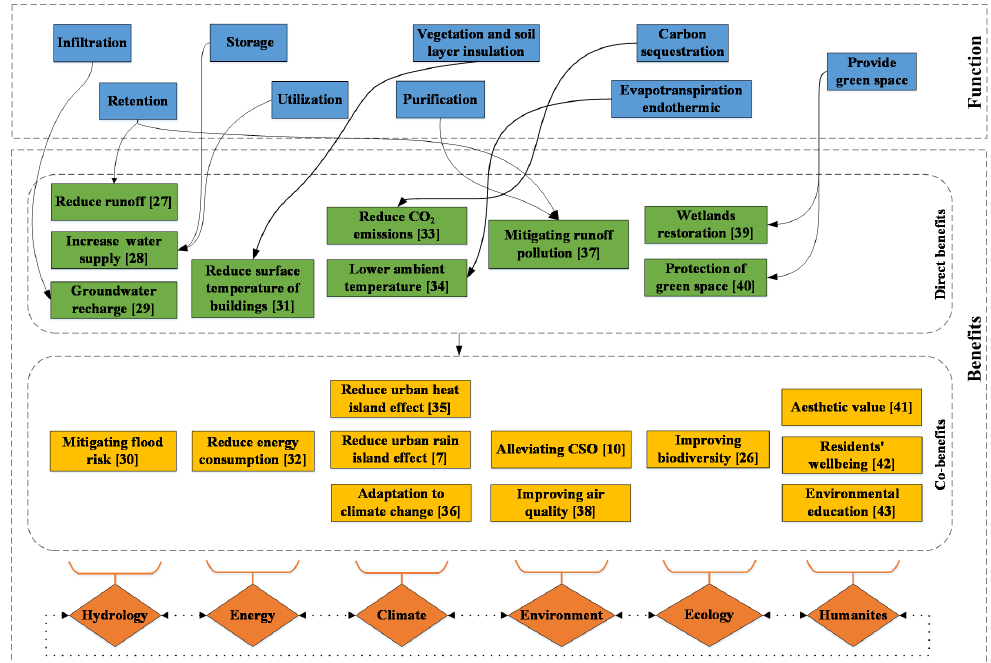
Figure 2. The effectiveness of green infrastructure (GI) and the relationships between the